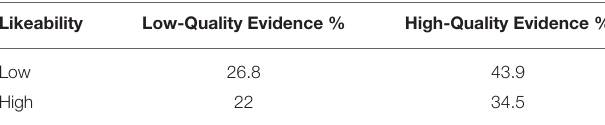
TABLE 4 | Proportion of participants selecting death sentence by evidence quality and likeability